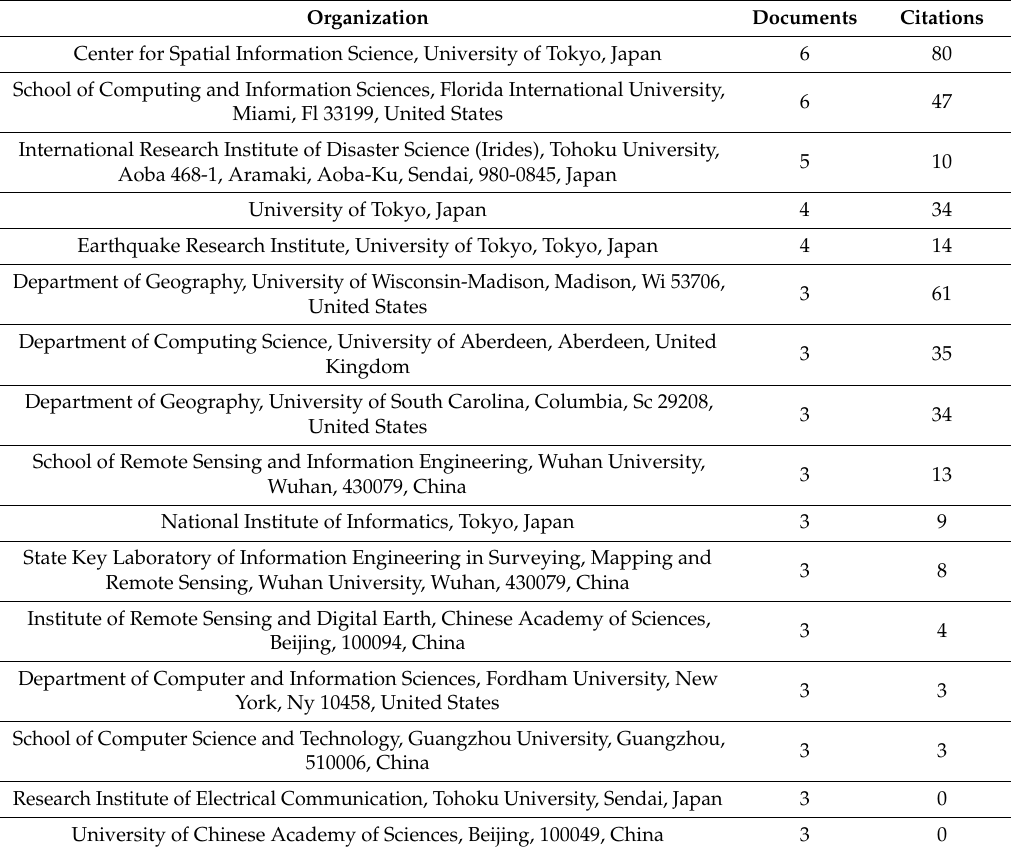
Table 5. List of a ffi liated organizations and the number of contributing documents included in the 139 reviewed articles from 2010 to